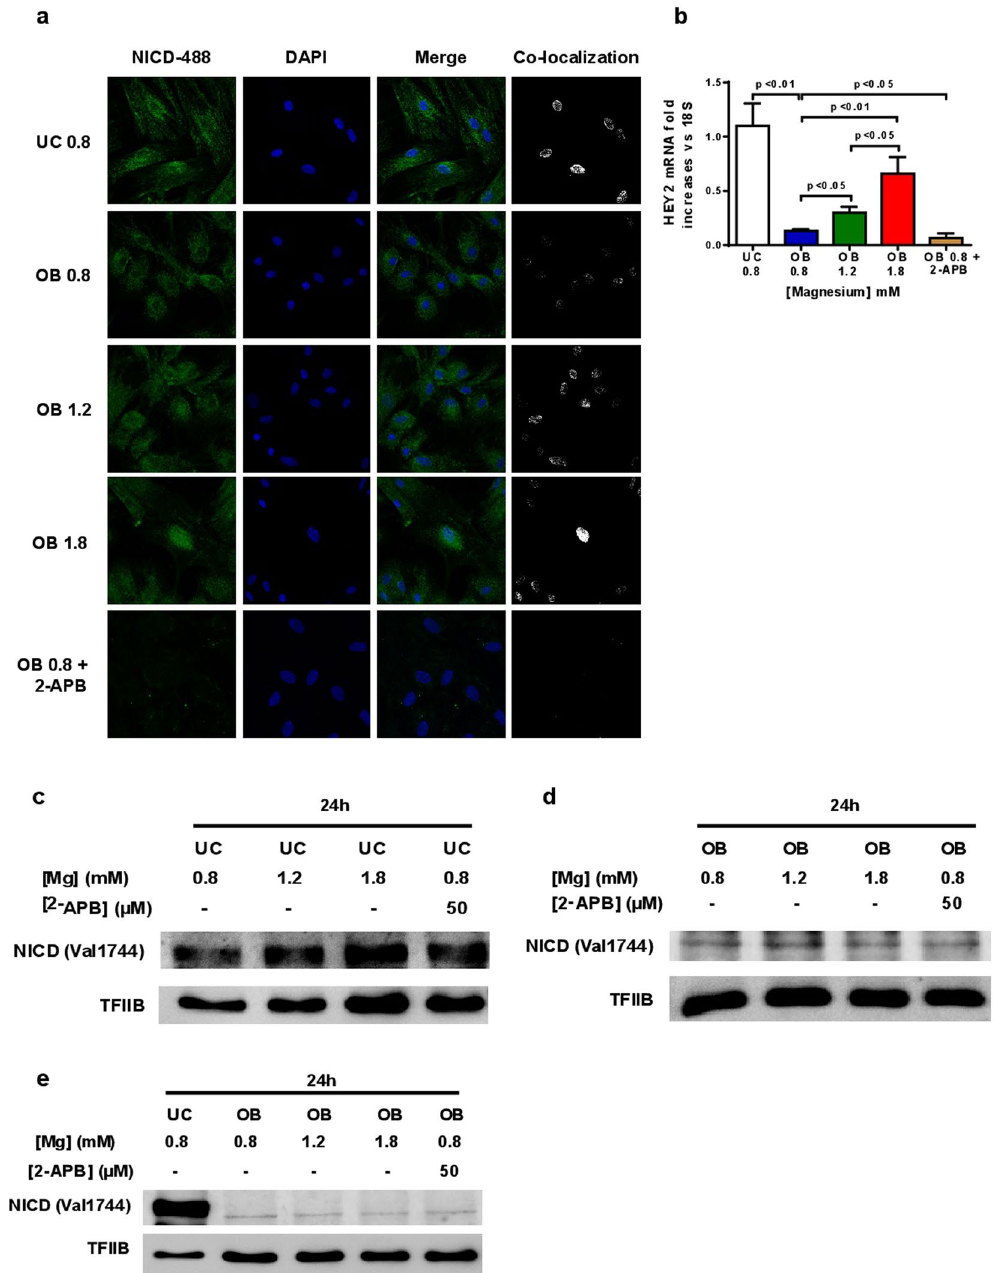
Figure 4. Moderately high Mg 2 + levels induce Notch signaling activation. ( a ) Confocal microscopy of NICD protein in undifferentiated MSC (UC 0.8 mM), differentiated osteoblasts with basal levels of Mg (OB 0.8) or plus Mg supplementation at 1.2 mM (OB 1.2) or 1.8 mM (OB 1.8 mM) and osteoblasts with Mg channel block (OB 0.8 + 2-APB). First column represents NICD immunostaining in green color; second column corresponds with nuclei staining with DAPI; the third column is a merge composition of green and blue staining while the last column shows green pixels that matches with blue pixels. ( b ) Gene expression of the Notch target gene HEY2. ( c ) Western blot for nuclear NICD in undifferentiated MSC after 24 h of stimulus with Mg 2 + . ( d ) Nuclear protein levels of NICD after 24 h of osteogenic stimulus with Mg 2 + or 2APB. ( e ) NICD expression in MSC and differentiated osteoblast from MSC plus 24 h of Mg 2 + stimulus after 21 days of